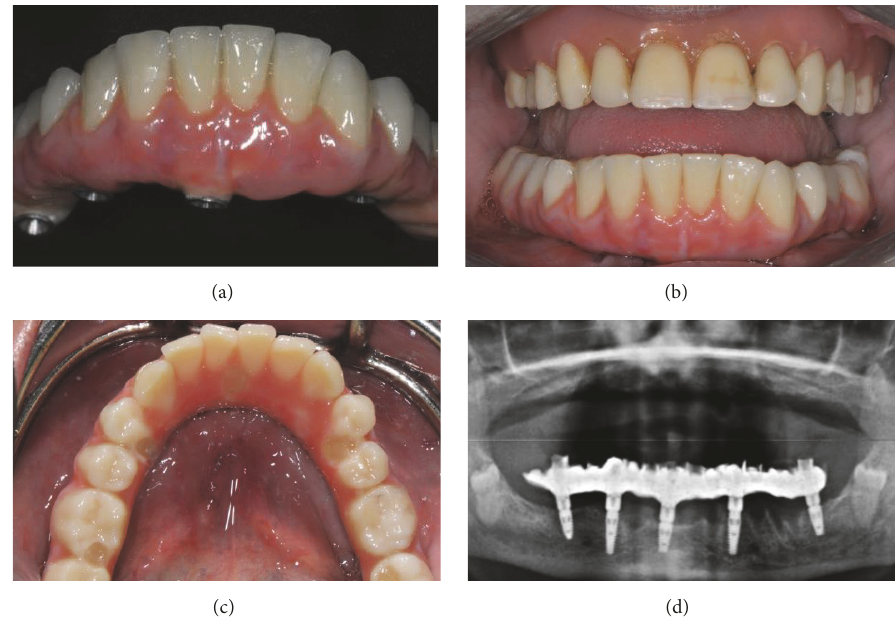
Figure 10: The fabrication of the prosthesis is completed in the laboratory (a), which after a few hours return the Toronto Bridge to the dentist for clinical application. The clinician delivers the prosthesis to the patient (b), after a careful check of the occlusion that must be perfectly balanced; then, the clinician closes the holes of the cylinders with Teflon soaked in chlorhexidine 5% and light curing flowable composite resin (c). The panoramic radiograph shows the titanium framework and the perfect adaptation of this structure on implant abutments